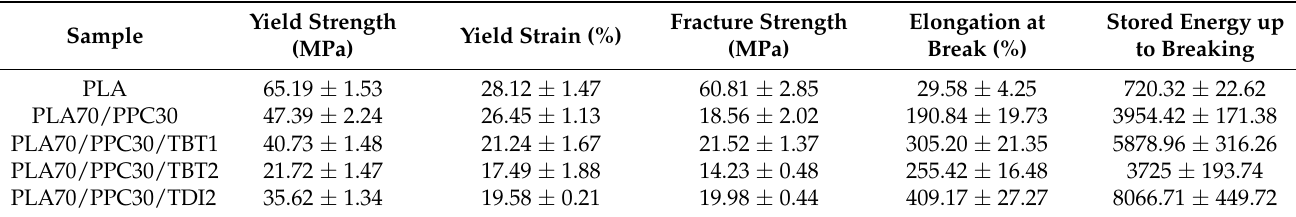
Figure 8. Tensile curves of PLA and PPC, its blend with PPC and the blends with 1–2% of TBT or 2% of TDI. Table 6. Mechanical property data of PLA, its blend with PPC and the blends with 1–2% of TBT or 2% of TDI.